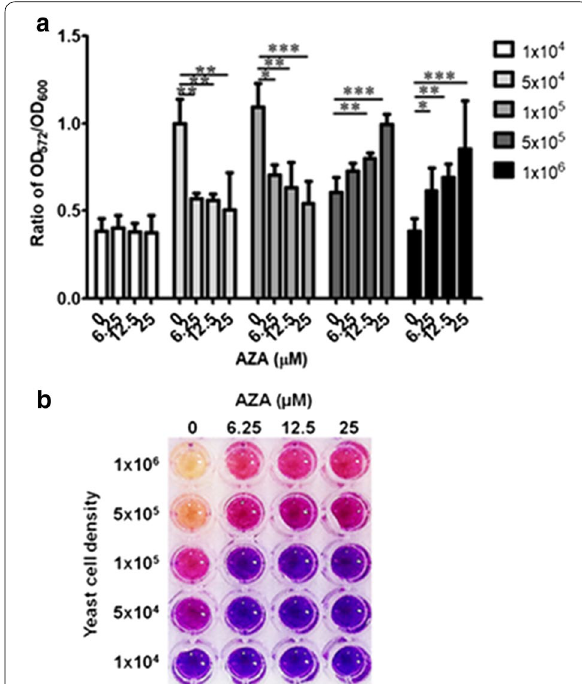
10 6 , 5 10 5 , 1 10 5 , 5 10 4 and 1 10 4 × × × × × Ade Leu His medium were added + + +